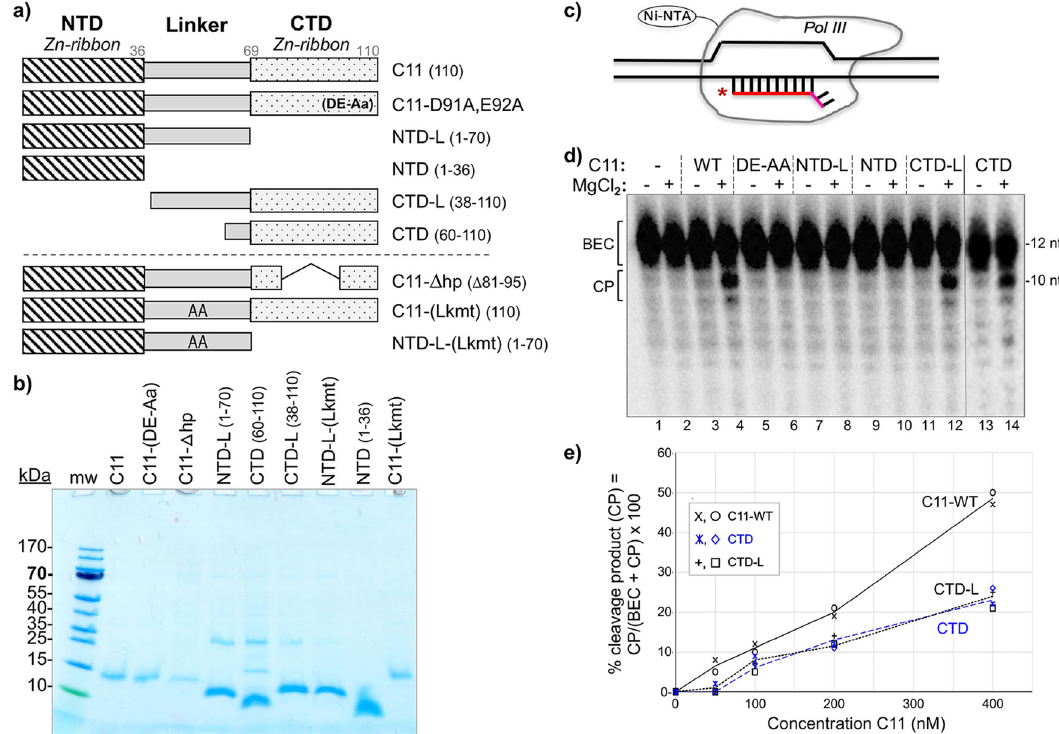
Fig. 2 The isolated C-terminal domain (CTD) of C11 can activate RNA 3 ’ -cleavage in backtrack arrested Pol III. a Diagram of the C11 constructs used in this study; the ones above the dashed horizontal line are used in this fi gure. b Coomasie blue-stained gel of the C11 proteins used, corresponding to panel a . c Schematic of a DNA scaffold Pol III elongation complex (EC) in which the 3-end of the 12-nt RNA (depected in red) has a 2-nt mismatch with the template, representing an arrested EC with a RNA 3 ′ -overhang in a backtracked state; the asterisk represents the radiolabeled 5 ′ - 32 P. d RNA 3 ′ -cleavage assay results. A batch of backtracked arrested EC substrate was aliquoted to different reaction tubes and incubated with either buffer alone or recombinant C11 as indicated above the lanes, for 15 min prior to addition of MgCl 2 as indicated. Total RNA was analyzed. The starting material, backtracked EC, and cleavage products, BEC and CP, are indicated by brackets; the image in lanes 13 – 14 was from the same assay run on a different gel. Positions of 12-nt and 10-nt RNAs are indicated to the right. e The fraction of CPs, calculated as % cleavage product (CP) = CP/(BEC + CP) × 100, were quanti fi ed and calculated with Multigauge V3.2 software 39 and plotted against the concentration of C11, CTD, and CTD-L. Two data points for each concentration are representative of independent biological replicates for the same batch of C11 construct proteins, as indicated in the inset. The means of the two points were used to plot the lines for the proteins annotated. Additional assay data are shown in Supplementary Fig. 1a. Linear regression analysis of these quanti fi ed data with R 2 values is shown in Supplementary Fig.